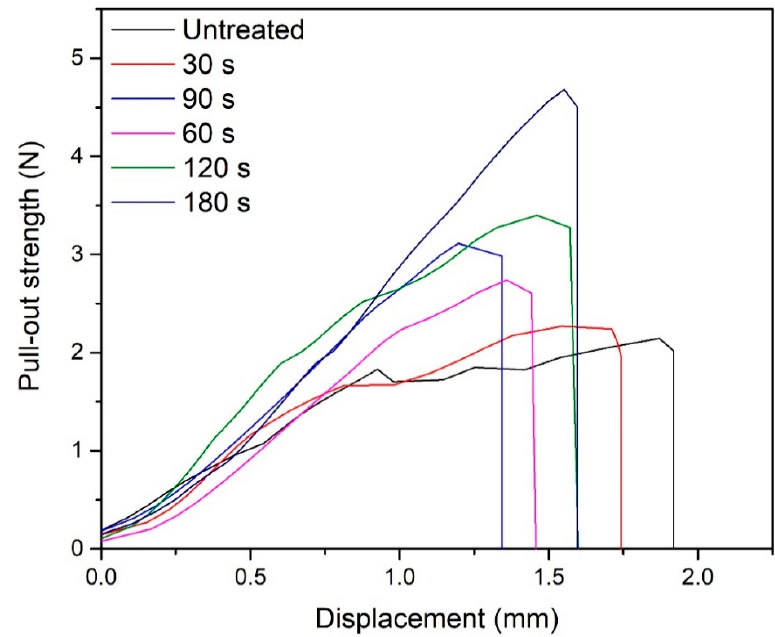
Figure 9. Pull-out bonding strength of DBD plasma-treated POM fibers for different durations.